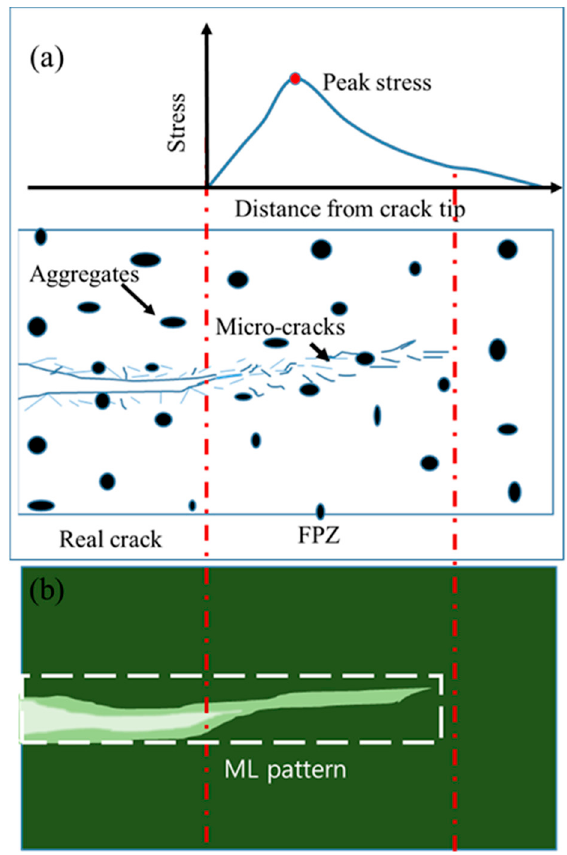
Figure 5. ( a ) Stress profile ahead of a crack tip in concrete material where the FPZ has the maximum stress concentration. ( b ) Schematic diagram showing the ML intensity from ML paint on a concrete sample. Among the three different colors, the dark green illustrates long phosphorescence, the lightest green depicts the emission from a recently propagated crack, and the remaining lighter green is the emission from a microcracking zone.